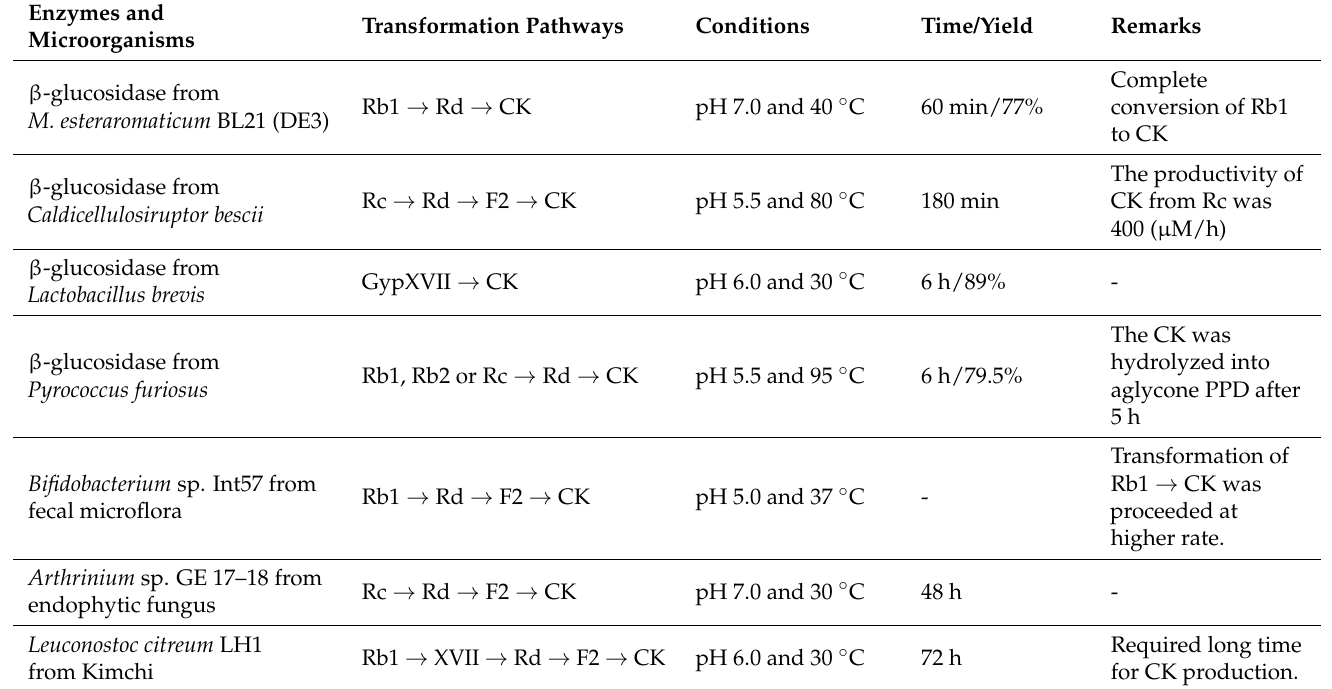
Table 1. Enzymatic and microbial transformation methods for the production of